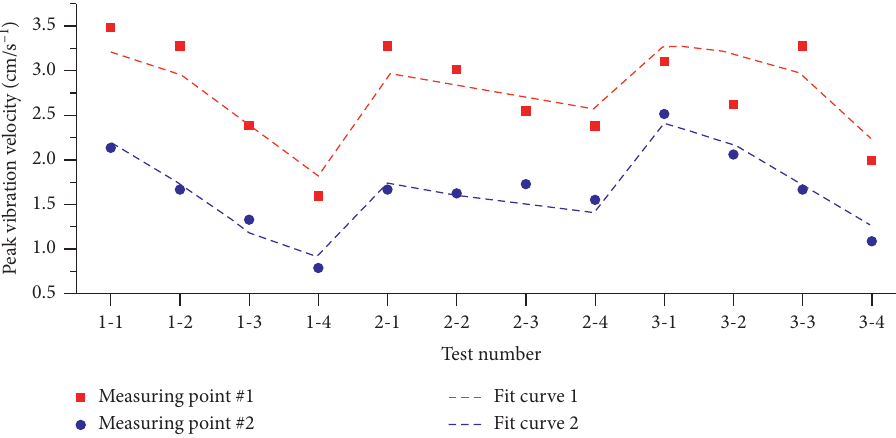
Figure 15: Regression fitting for the PPV and three factors.